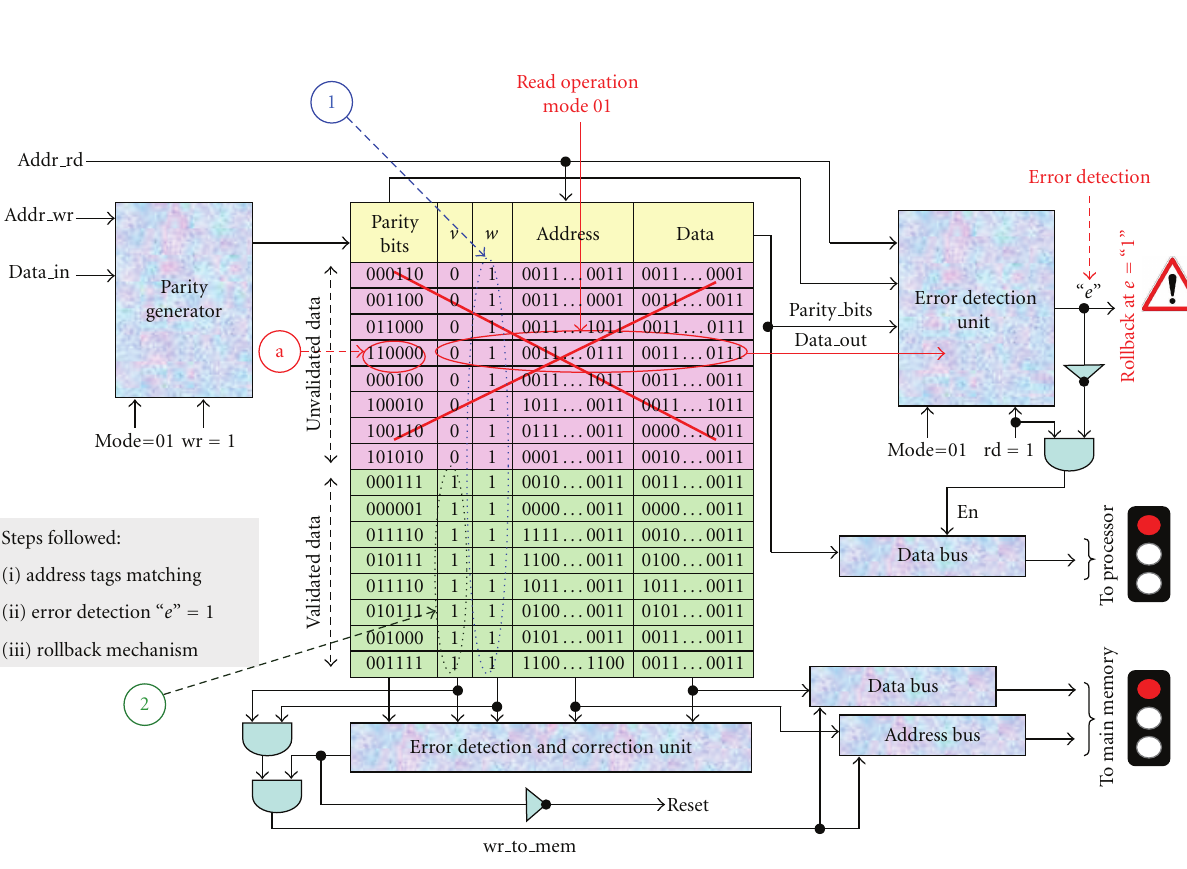
Figure 10: SCHJ relations in mode 00.